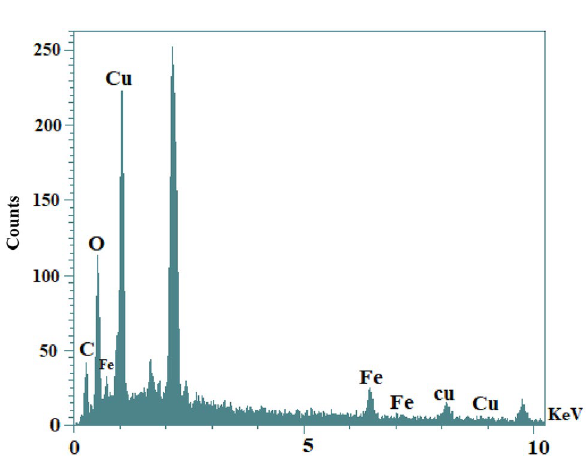
Figure 7. The EDX spectrum of CuFe 2 O 4 @CQD